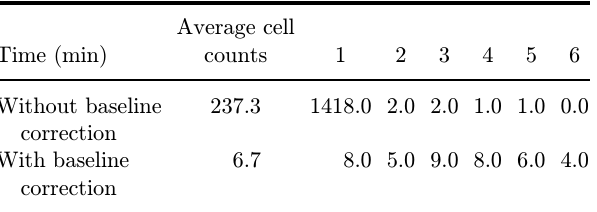
Table 1. Cell count results for a signal with baseline intensity change.